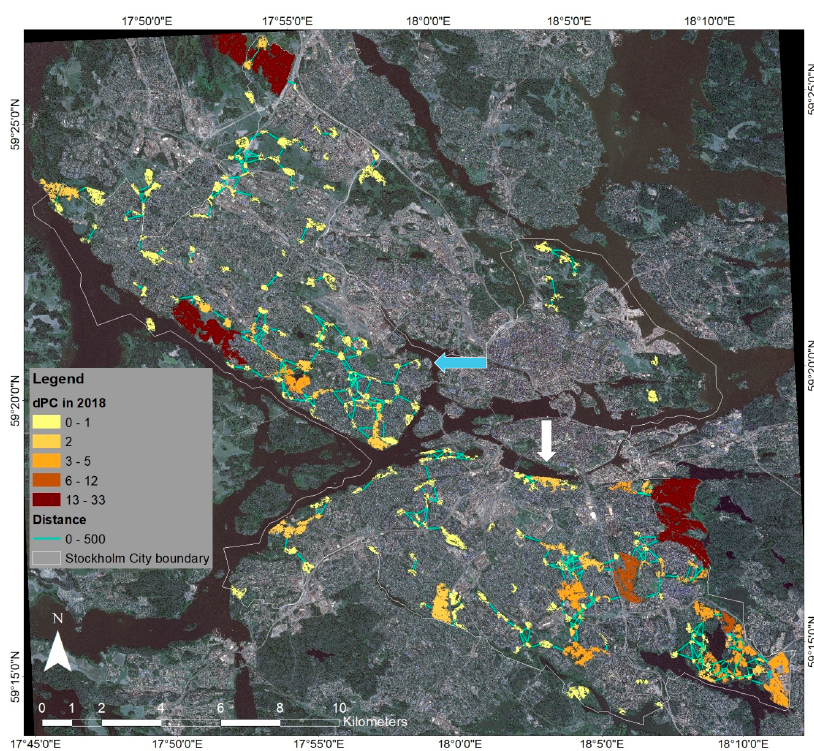
Figure 12. Distance links (up to 500 m) connecting patches of crested tit habitat in 2018. Links are shown in green and patches are shown in colors corresponding to their dPC values.